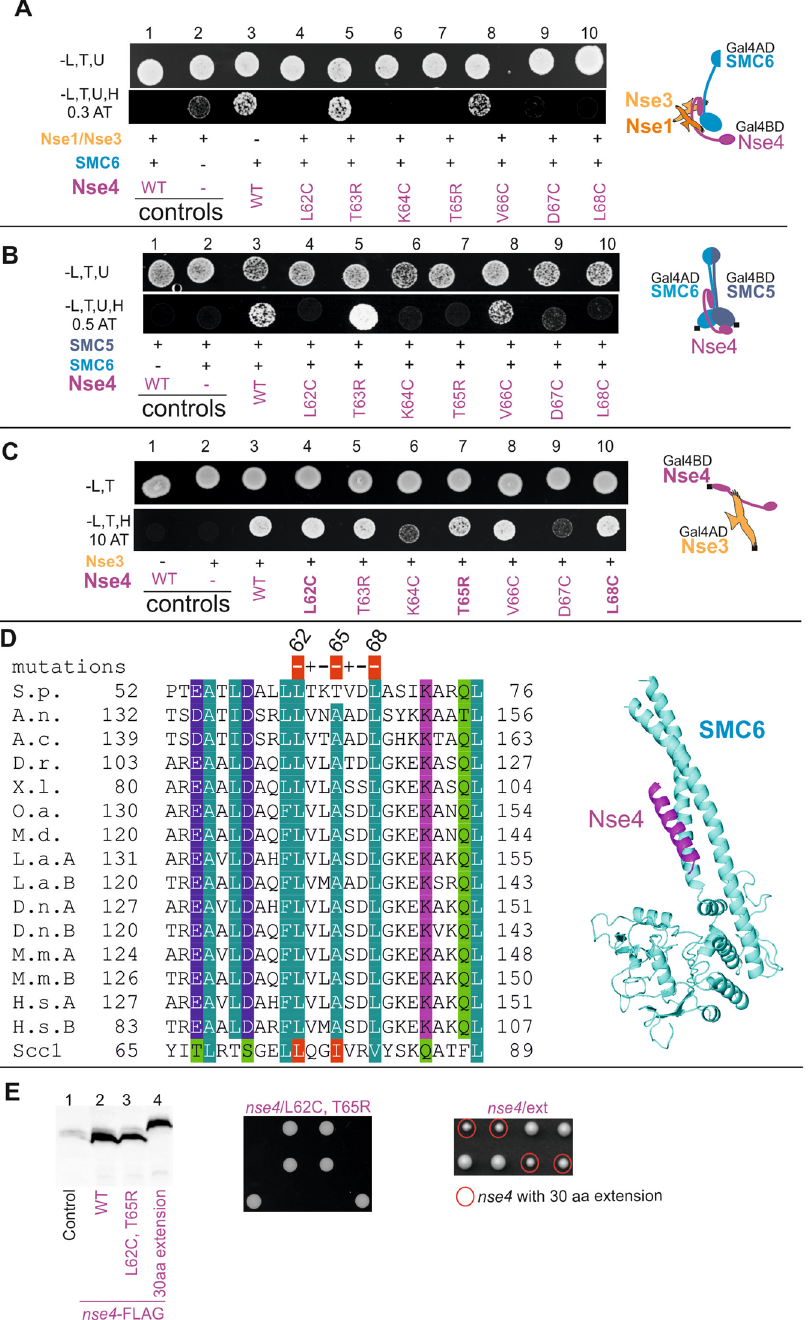
Figure 2. Binding of the Nse4 helix H3 to SMC6 is essential for yeast viability. Identification of the SMC6- binding residues within the Nse4 helix H3 region (aa62-68; A – D ). ( A ) Stability of the SMC6-Nse4-Nse3-Nse1 complex was scored by 4Y2H on the plates containing 0.3 mM 3-Amino-1,2,4-triazole (-L,T,U,H, 0.3 AT panel). ( B ) Stability of the SMC5-Nse4-SMC6 complex was scored by 3Y2H on the plates containing 0.5 mM 3-Amino- 1,2,4-triazole (-L,T,U,H, 0.5 AT panel). The Nse4/L62C, K64C, T65R, D67C, and L68C mutations reduce stability of the SMC6-Nse4-Nse3-Nse1 as well as SMC5-Nse4-SMC6 complexes. In the control experiment ( C ), the same mutations were tested for the Nse4-Nse3 interaction in the classical Y2H system (constituted of the full-length Gal4BD-Nse4 and Gal4AD-Nse3). Interactions were scored on plates containing 10 mM 3-Amino- 1,2,4-triazole (-L,T,H, 10AT panel). The K64C and D67C mutations affect all Nse4 complexes ( A–C ). Intact L62, T65 and L68 Nse4 residues are required specifically for binding to SMC6 ( A , B ). Wild-type (WT) or mutant versions of Nse4 are labelled in violet below the panels (further details as in Fig. 1). ( D ) Alignment of the Nse4 helix H3 (of the N-terminal HTH domain). The Scc1 sequence from S. cerevisiae represents the kleisin binding mode present in the SMC3-Scc1 crystal structure (PDB: 4UX3). The organisms and figure legends are same as in the Fig. 1A; note that there are two Nse4 genes in the placental mammals denoted as A and B. The SMC6- Nse4 model (right) is based on the protein-protein interaction analysis. ( E ) The Nse4-3xFLAG constructs